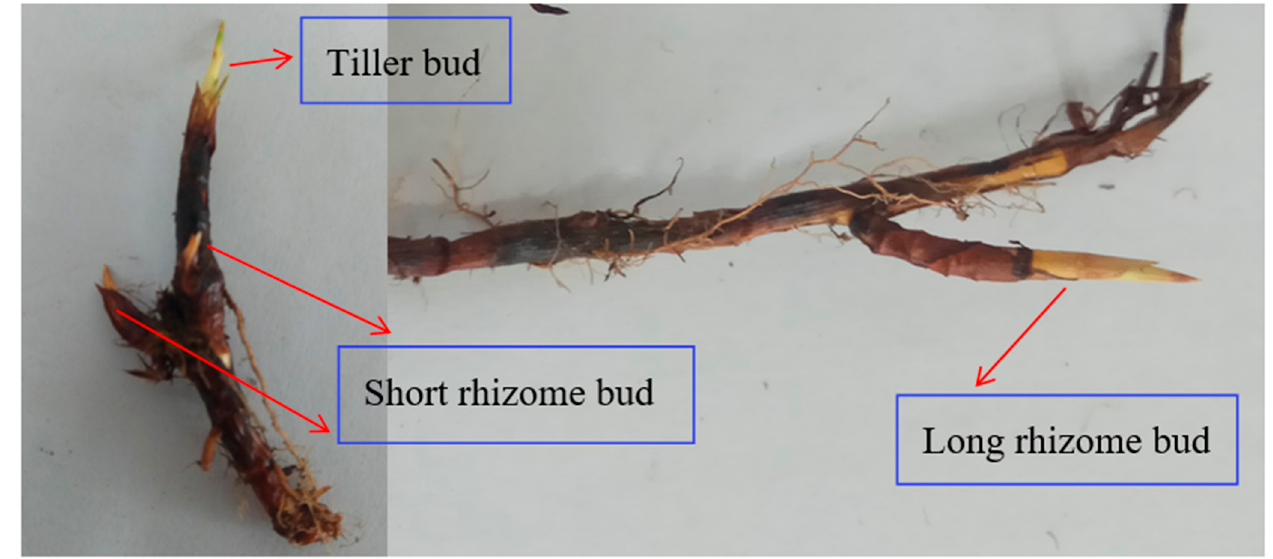
Figure 2. The three investigated bud types.